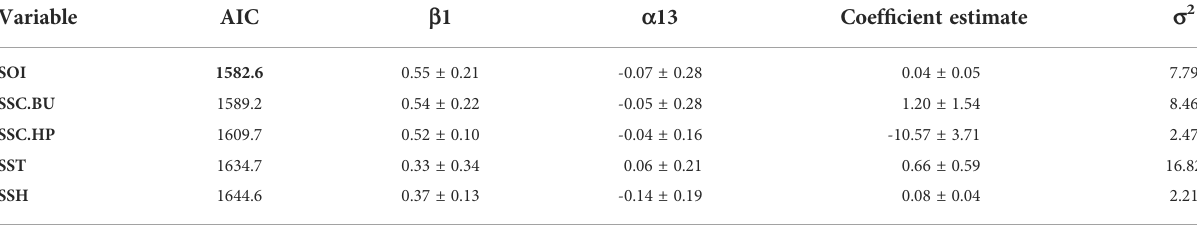
TABLE 1 Univariate models obtained from the monthly time series analysis with whale call count data.